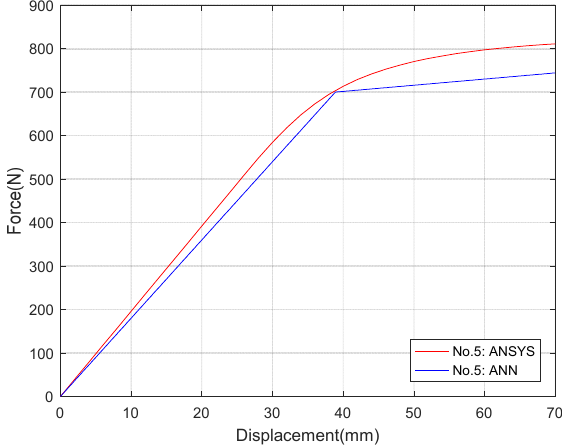
Figure 17. Estimated load–displacement curve (first coil damper).